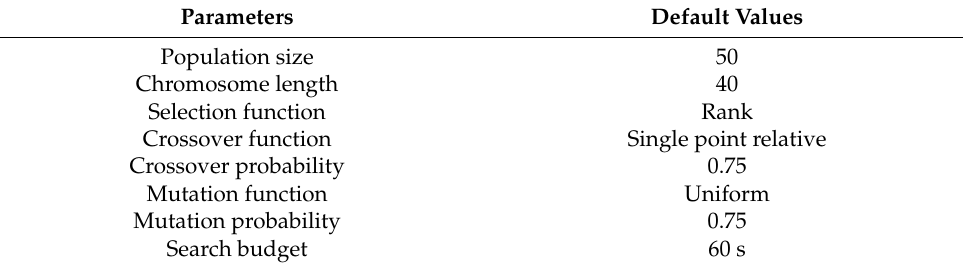
Table 3. Default values of parameters in Evosuite.